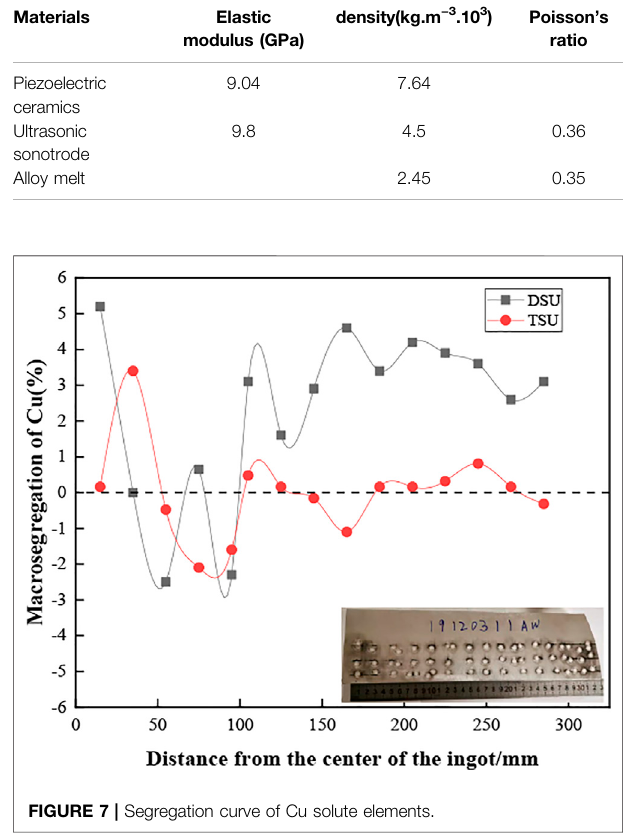
FIGURE 7 | Segregation curve of Cu solute